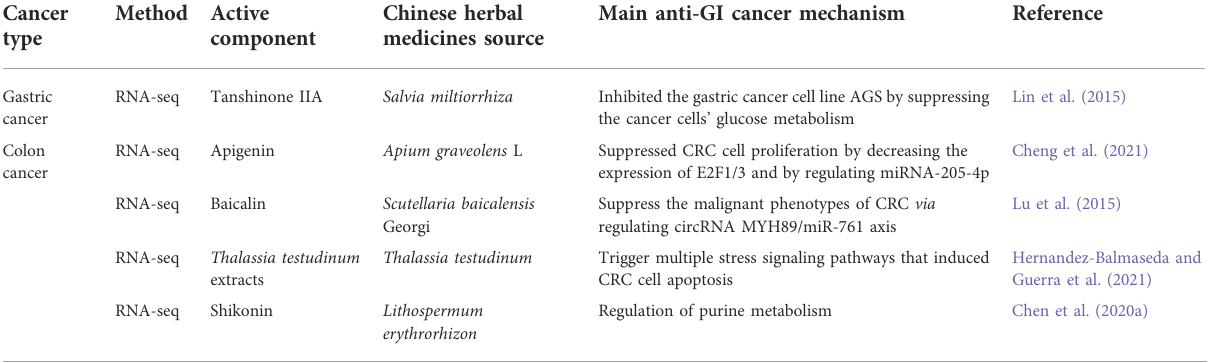
TABLE 4 Applications of transcriptomics approaches to study Chinese herbal medicines in GI.